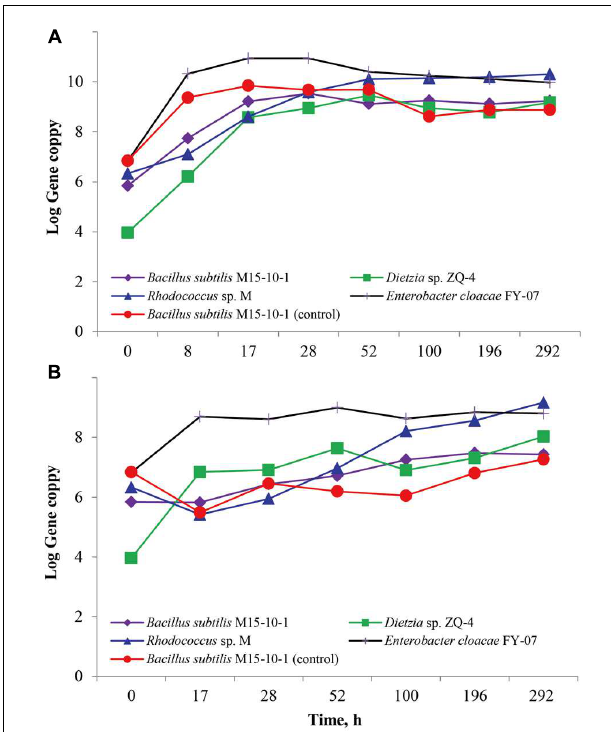
FIGURE 4 | Growth curves of Bacillus subtilis M15-10-1, Dietzia sp. ZQ-4, Rhodococcus sp. M, and Enterobacter cloacae FY-07 in an artificial microflora cultured on LB (A) and BSM (B) medium. Bacillus subtilis M15-10-1 (control): Growth curves of Bacillus subtilis M15-10-1 in LB (A) and BSM (B)